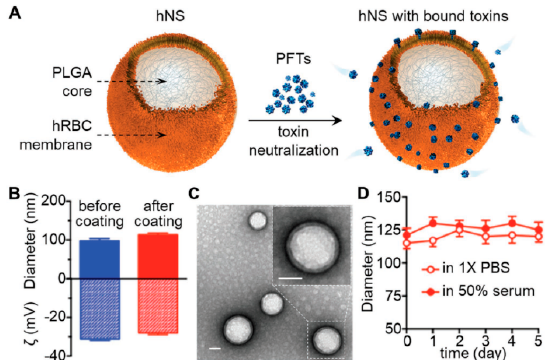
Figure 8. ( A ) Schematic of the biomimetic nanosponges and neutralization of the pore-forming toxins (PFTs) mechanism. ( B ) Dynamic light scattering measurement of the NP hydrodynamic size and zeta potential. ( C ) TEM image of the nanosponge. ( D ) Stability of the NP. Reproduced with permission from Ref. [142], Copyright © 2018 WILEY-VCH Verlag GmbH & Co. KGaA, Weinheim, published Feb 13,